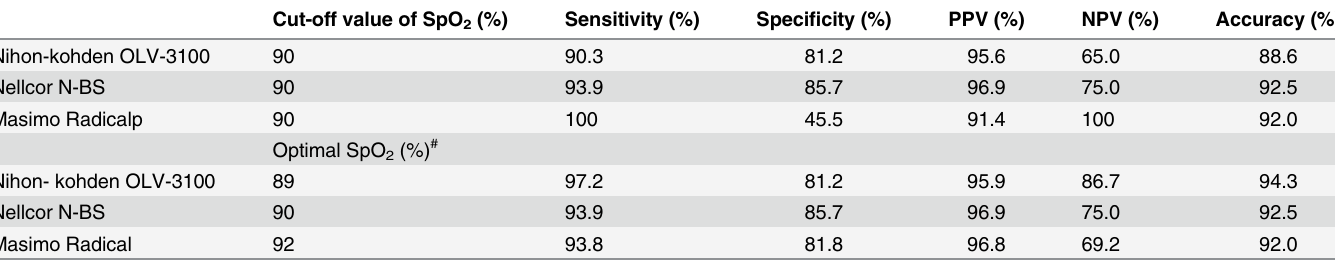
Table 5. Optimal SpO 2 value and ability of 3 pulse oximeters to detect hypoxemia (SaO 2 ≦ 90%). Cut-off value of SpO 2 (%)